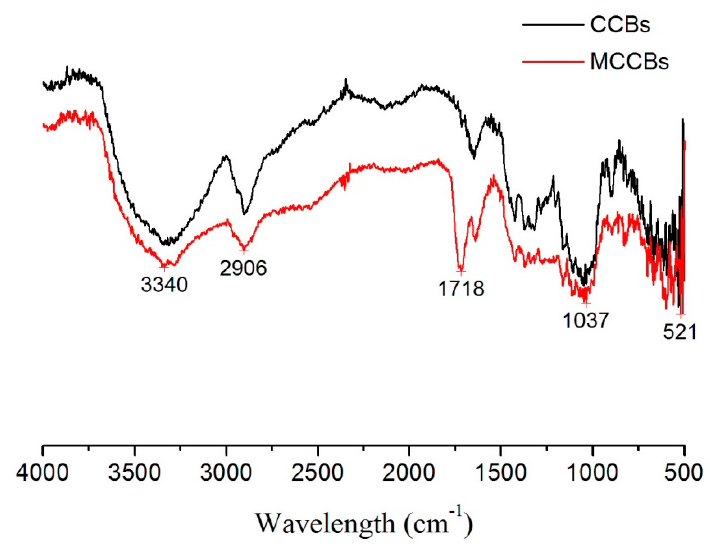
Figure 1. FT-IR of CCBs and MCCBs.